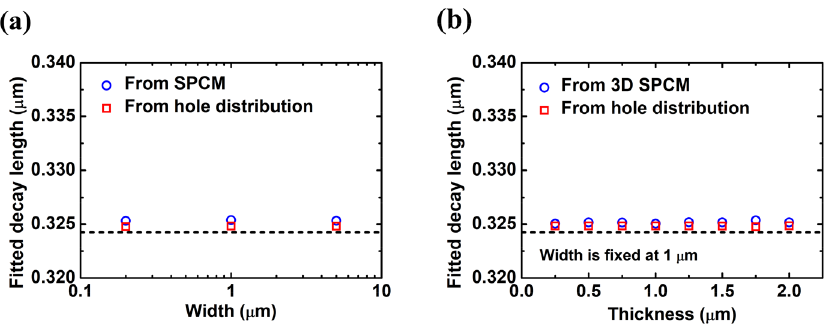
Figure 3. Fitted decay lengths extracted from scanning photocurrent profiles and from integrated photo- induced hole distributions ( a ) in 2D transport structures with different width and ( b ) in 3D transport structures with different thickness while the width is fixed at 1 μm. Calculated decay length obtained from Eq. (2) is shown as the dashed